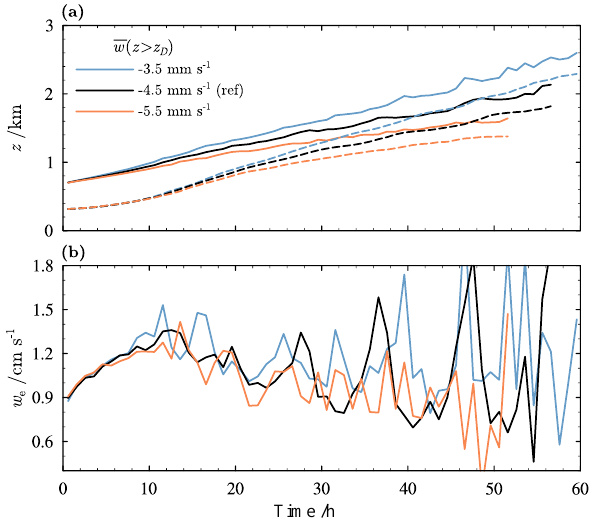
Figure 5. The inversion jumps (a) of total humidity (cid:49)q t and (b) of liquid water potential temperature (cid:49)θ l as a function of time for each of the sensitivity